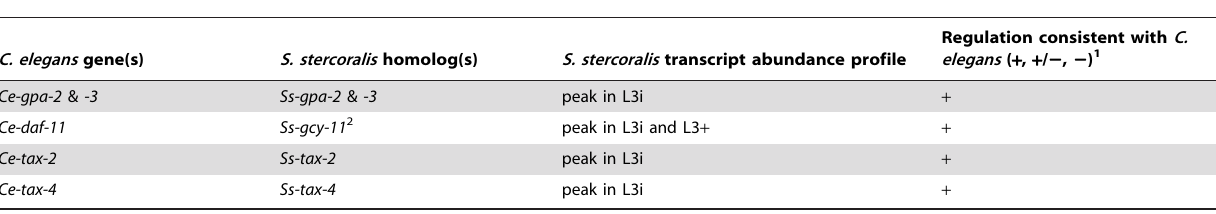
Table 1. Comparison of cGMP signaling pathway homologs and transcript abundances in S. stercoralis and C. elegans